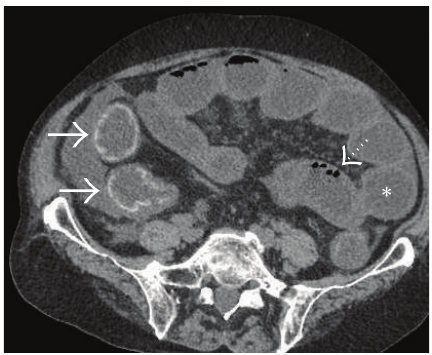
Figure 53: Axial CECT image showing nonenhancing loop of jejunum (arrow) due to SMV thrombosis.